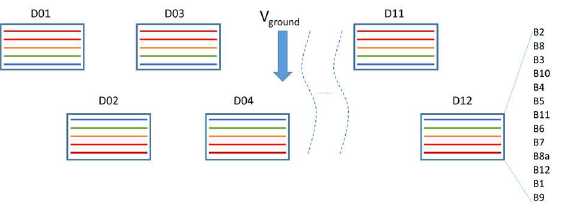
Figure 1 : Virtual focal plane layout mixing VNIR and SWIR focal planes. The yaw steering condition insures that V ground is orthogonal to the detector arrays.